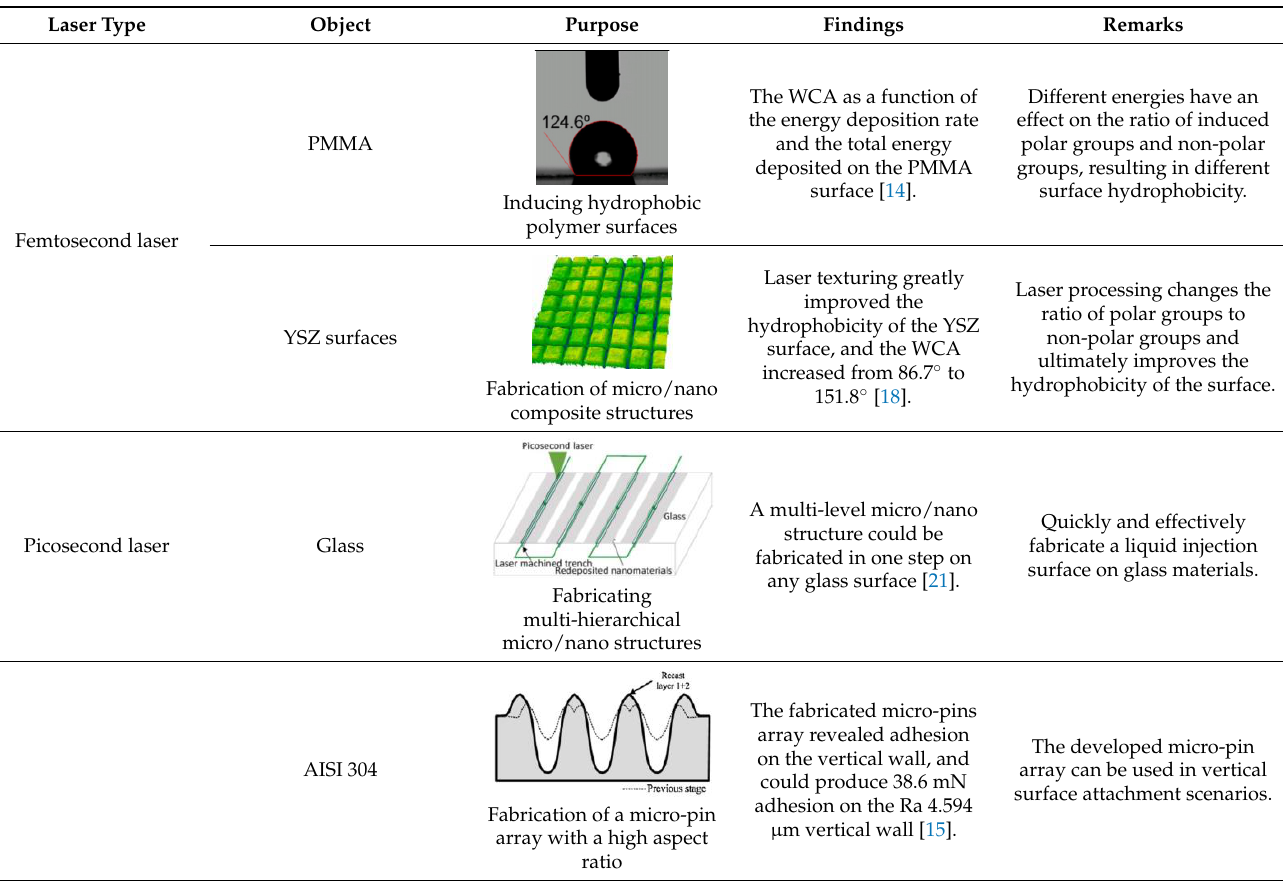
Table 1. Summary of the process of LBM described in the text grouped by laser type and object fabricated. Laser Type